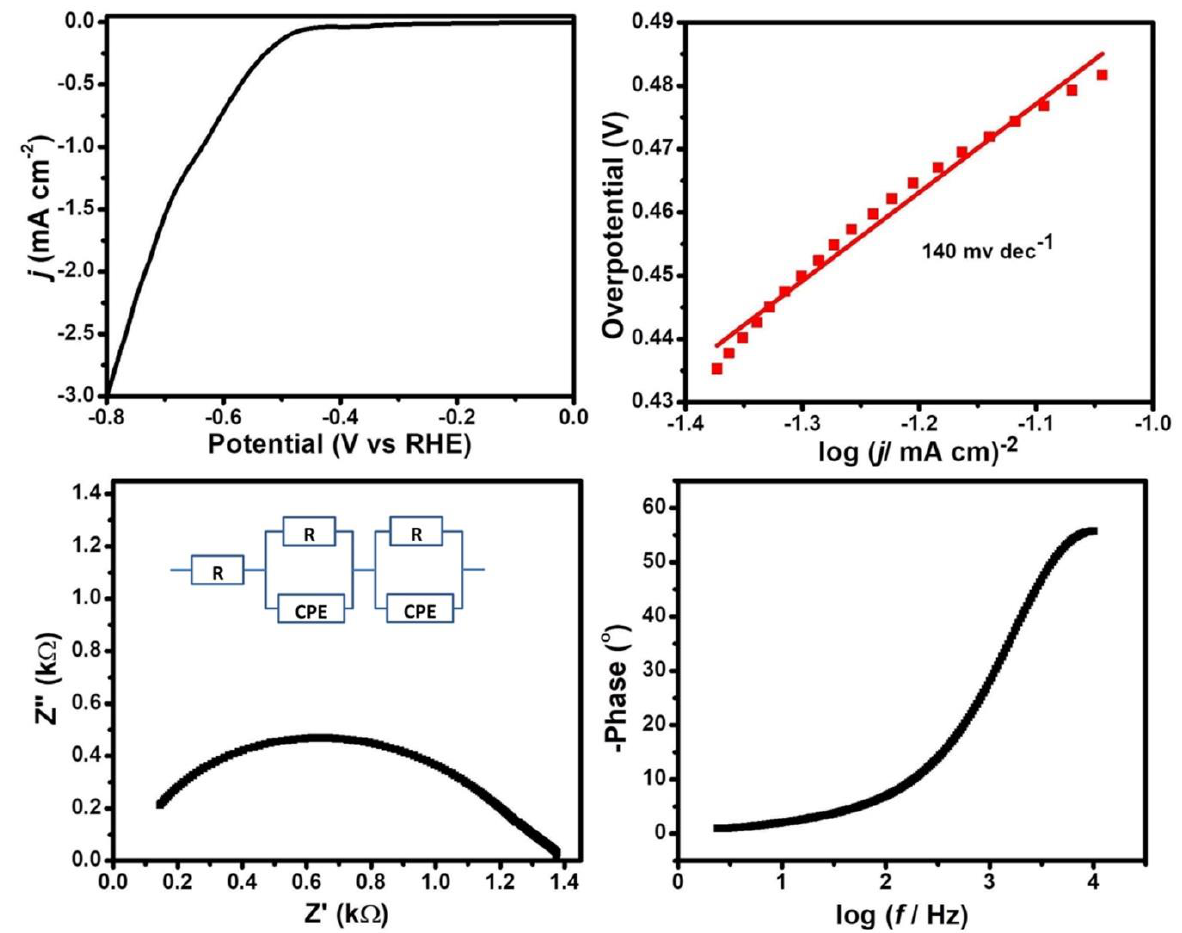
Figure 3. ( Top ) LSV plot at 1 mv sec − 1 scan rate and corresponding Tafel plot and ( bottom ) Nyquist (with equivalent circuit diagram) and Bode plots from the EIS study of Cu 2 WS 4 in 0.5 M H 2 SO 4 solution.